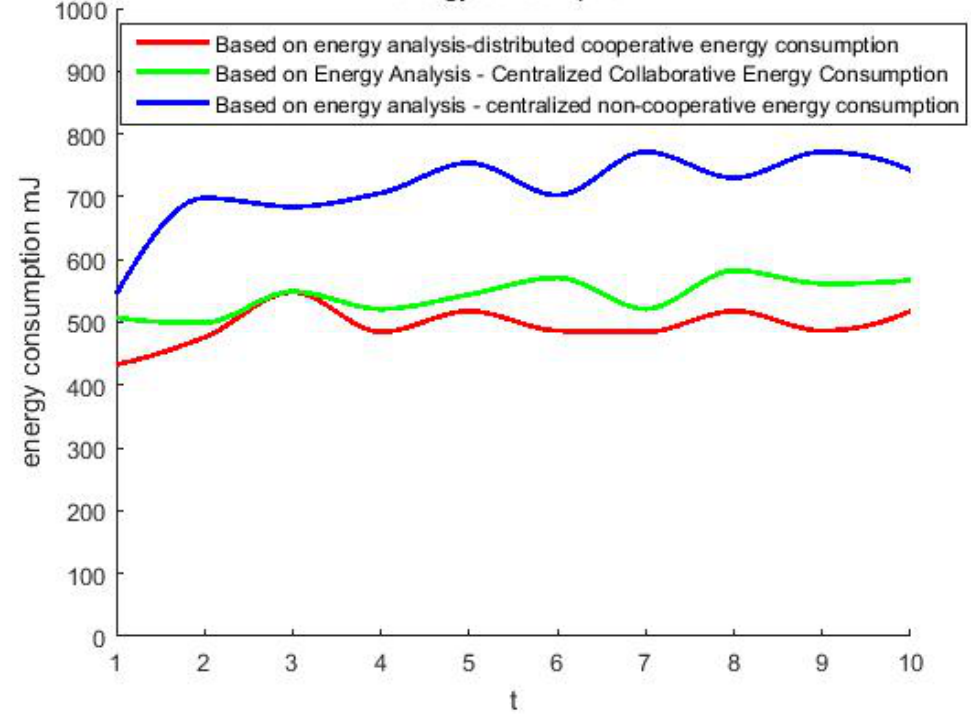
Figure 8. Energy consumption under different energy analysis-sensing methods.